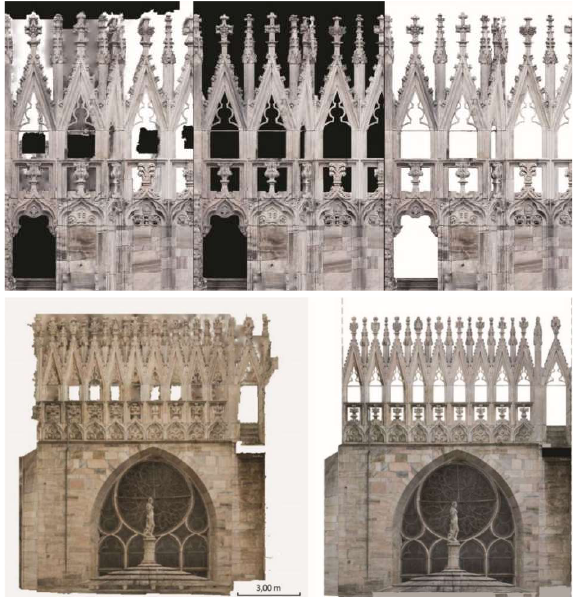
Figure 6. post processing of the orthophotos, manual masking of the rough edges resulting from an “abundant” mesh model that exceed the actual edge of the gothic